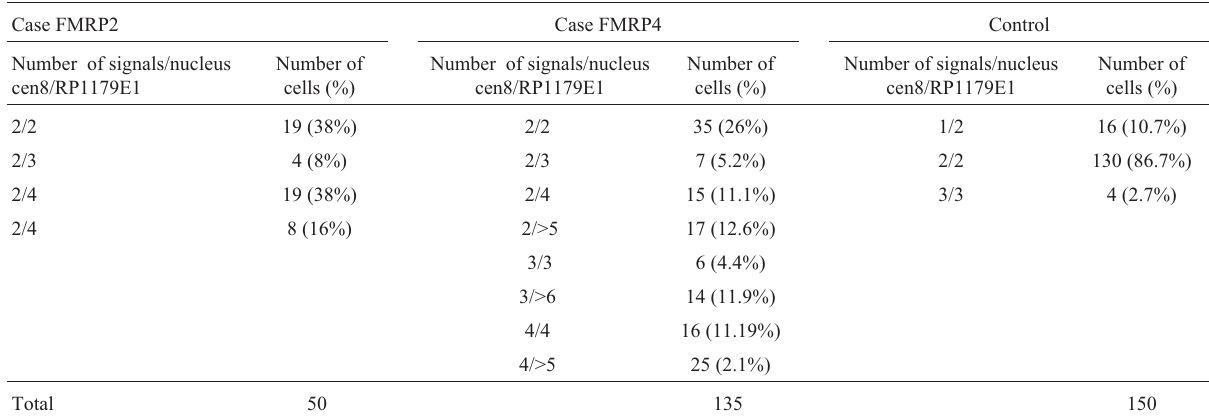
Table 3 - Interphase FISH analysis of chromosome 8 centromere copy number (probe PMJ 128 ) and gains at 8q23.2 (probe RPC 1179E1 ) in two osteosarcomas. Case